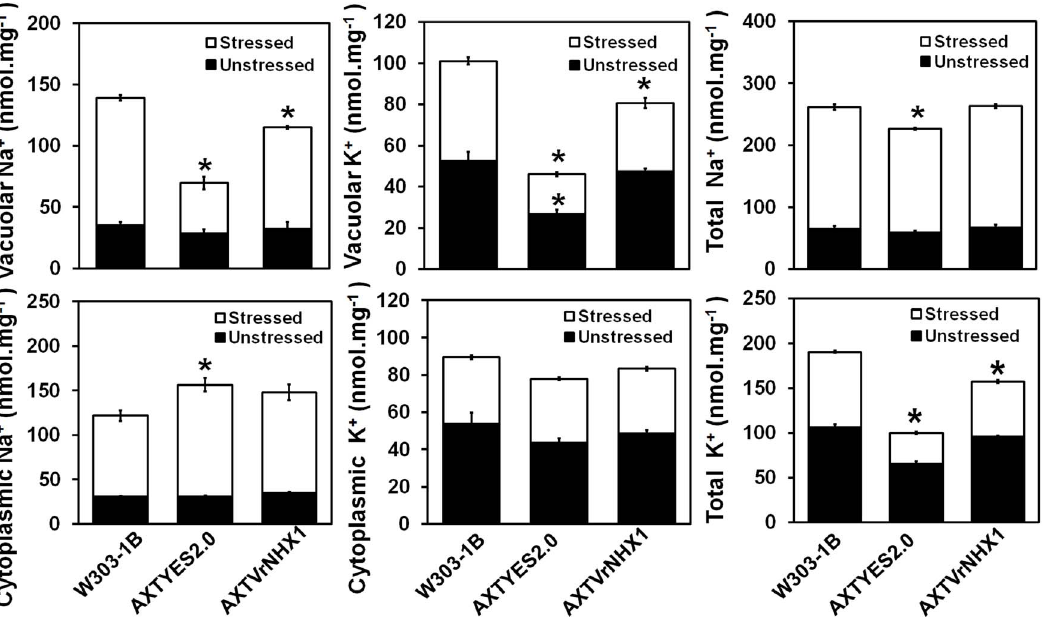
Figure 5. Total intracellular ion estimation in yeast strains W303-1B, AXTYES2.0 and AXTVrNHX1. Yeast cells were grown in APG medium (pH 4.0) with 1 mM KCl supplemented in presence (stressed) or absence of 75 mM NaCl (unstressed) and harvested at a cell density of 0.3. Total intracellular, vacuolar and cytoplasmic Na + and K + content was determined as described in the materials and methods section. Data are means of 3 independent events (n=3) and standard errors are plotted in the graph. Statistically significant values at P # 0.05 are indicated as ‘‘*’’, using Bonferroni analysis.